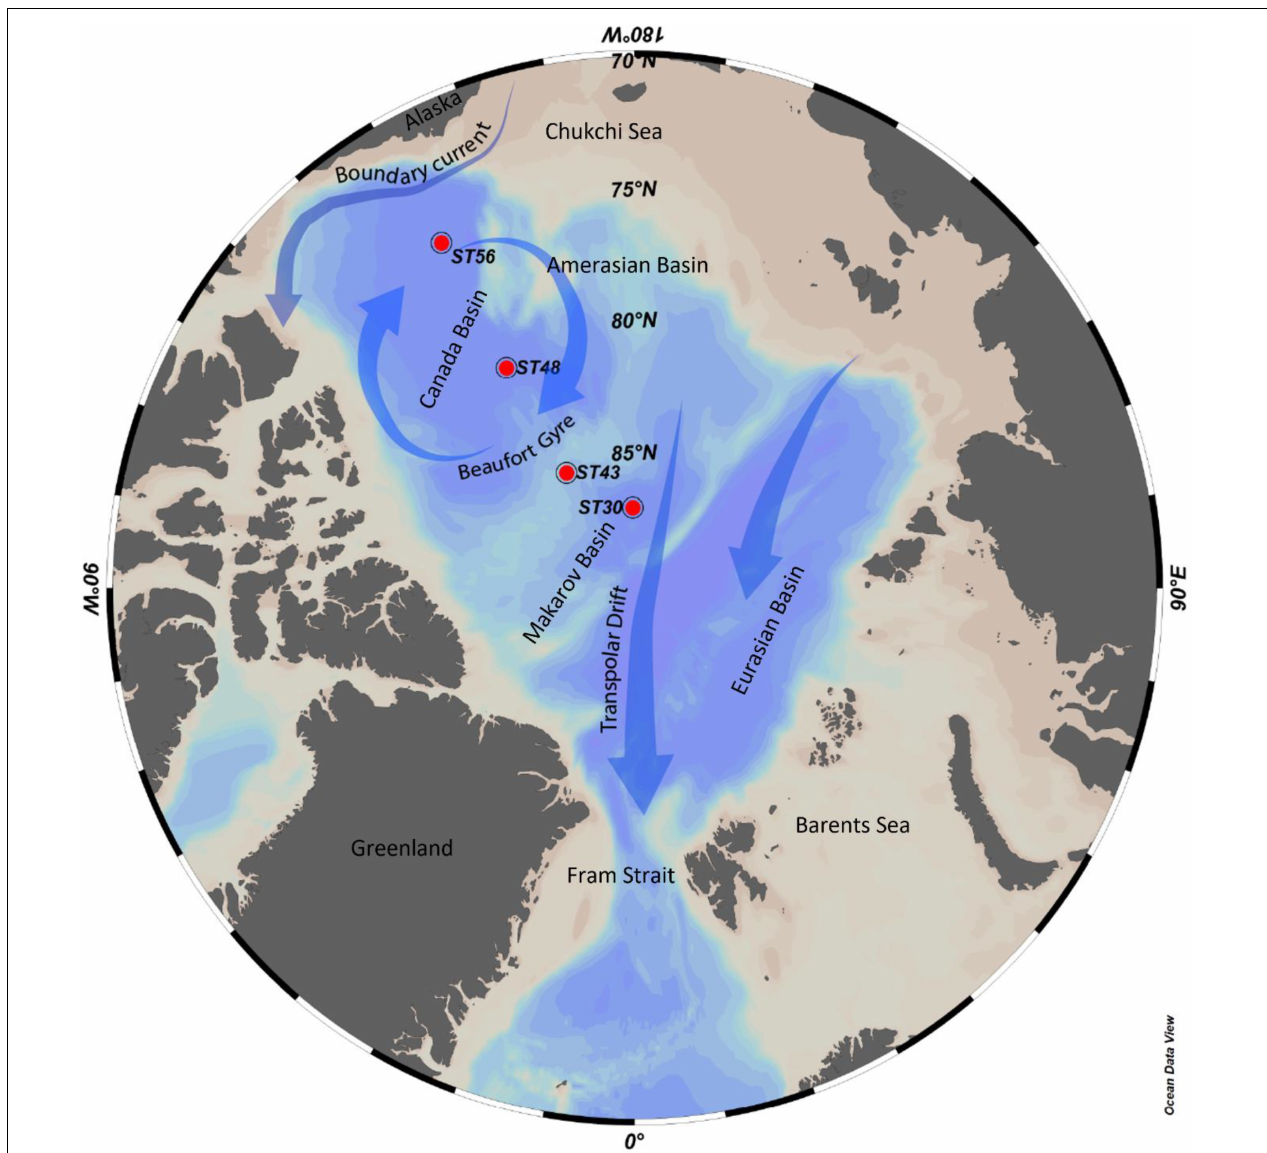
FIGURE 1 | Map showing the sampling stations 30, 43, 48, and 56 in the US Arctic GEOTRACES (GN01) section. Water samples for dissolved and particulate 210 Po and 210 Pb were collected onboard US Coast Guard Cutter Healy (HLY1502) from August 9th to October 11th, 2015. The arrows represent the major circulation pattern of the surface layer water mass. The map was created using Ocean Data View